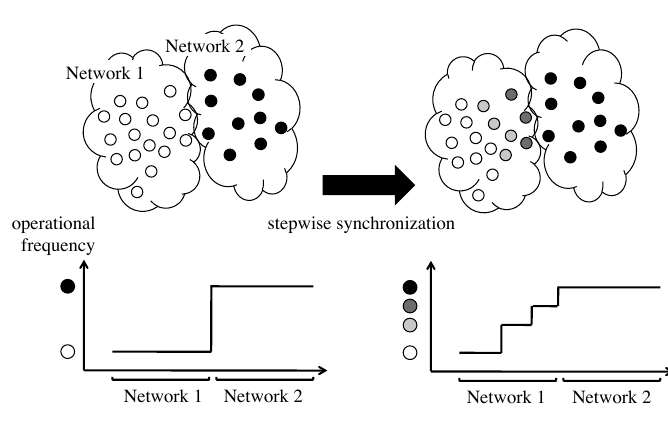
Figure 5. Stepwise synchronization.